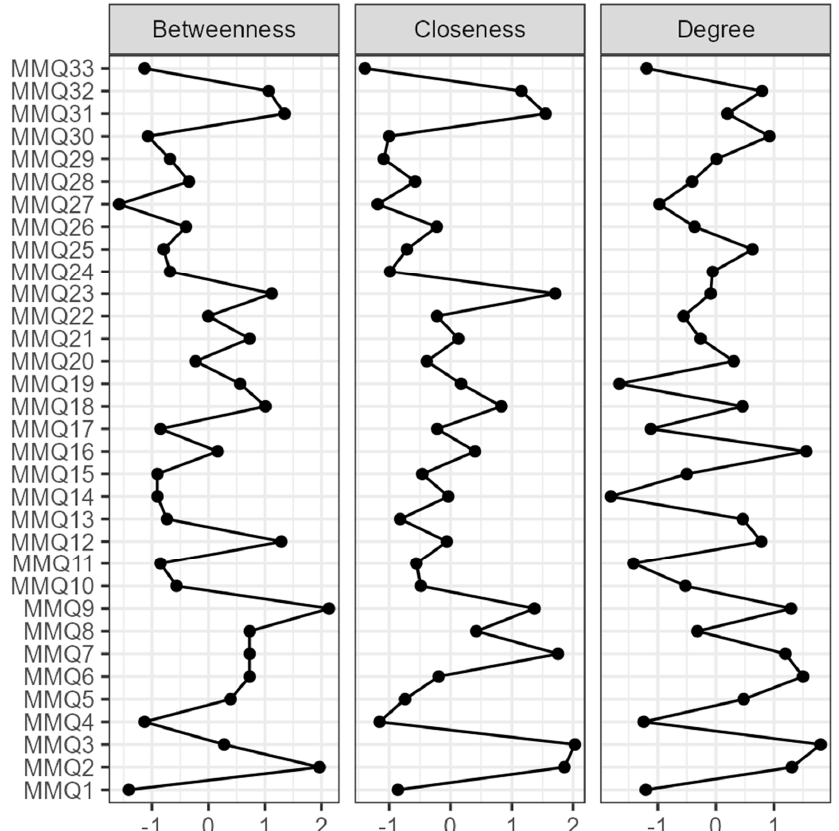
Figure 5. Centrality plot of the MMQ. For each index, higher values indicate greater centrality in the network.